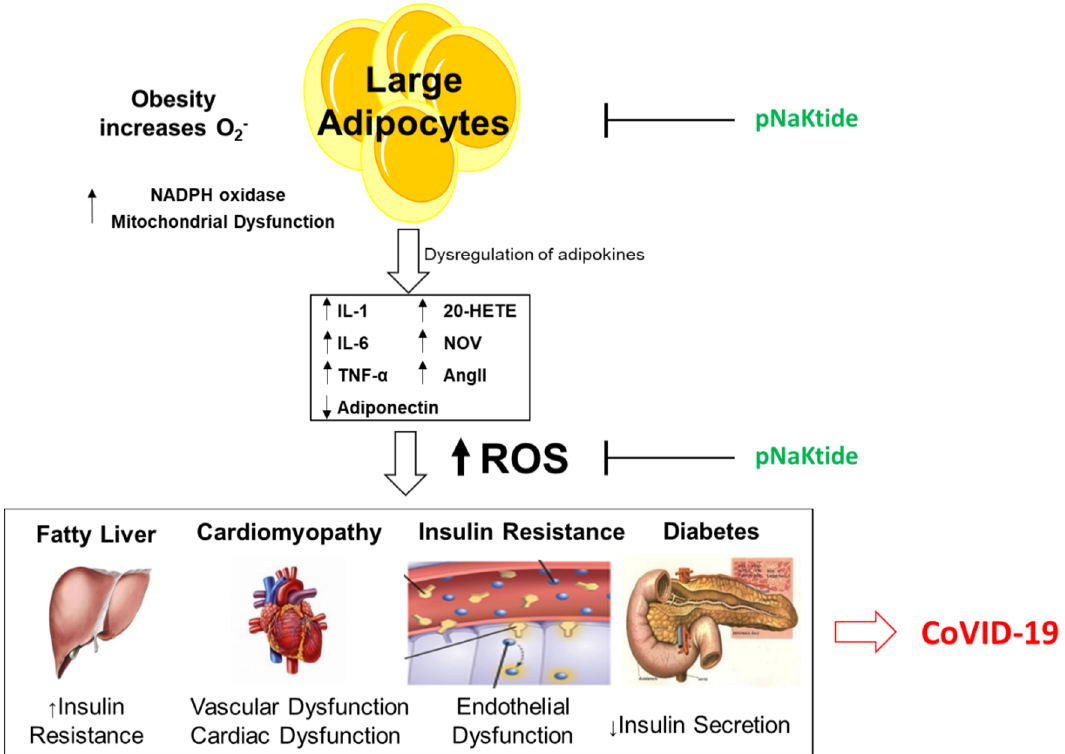
Figure 4. Obesity’s effect on cardiovascular disease, Fatty Liver, Cardiomyopathy and Diabetes exacerbating COVID-19.